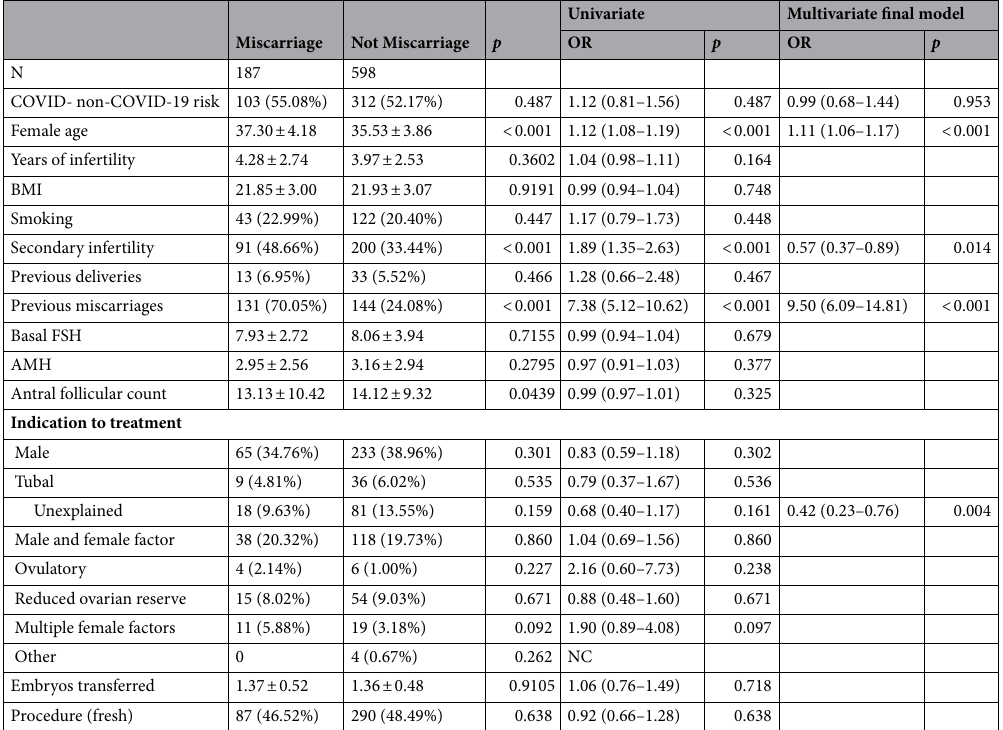
Miscarriage Not Miscarriage p